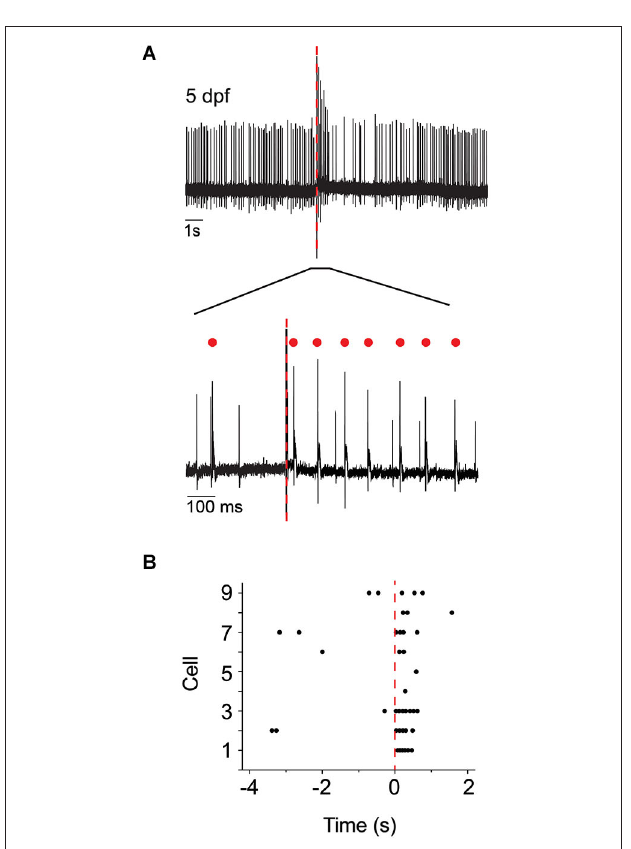
FIGURE 3 | Direct electrical stimulation of inferior olive increases occurrence of complex spike-like events. (A) Upper: The inferior olive was stimulated using a theta pipette (see Figure 1B ) at the time indicated by the red dashed line. Shown is a representative recording of Purkinje cell activity obtained at 5 dpf. Lower: The portion of the upper trace marked by a bar is shown on an expanded time scale. Red dots indicate complex spikes. (B) Peristimulus raster plot shows the occurrence of complex spikes before and after stimulation of the inferior olive at time 0 (red dashed line). Results were obtained from nine Purkinje cells from four animals at 5 dpf. The trace shown in panel (A) corresponds to cell #3.